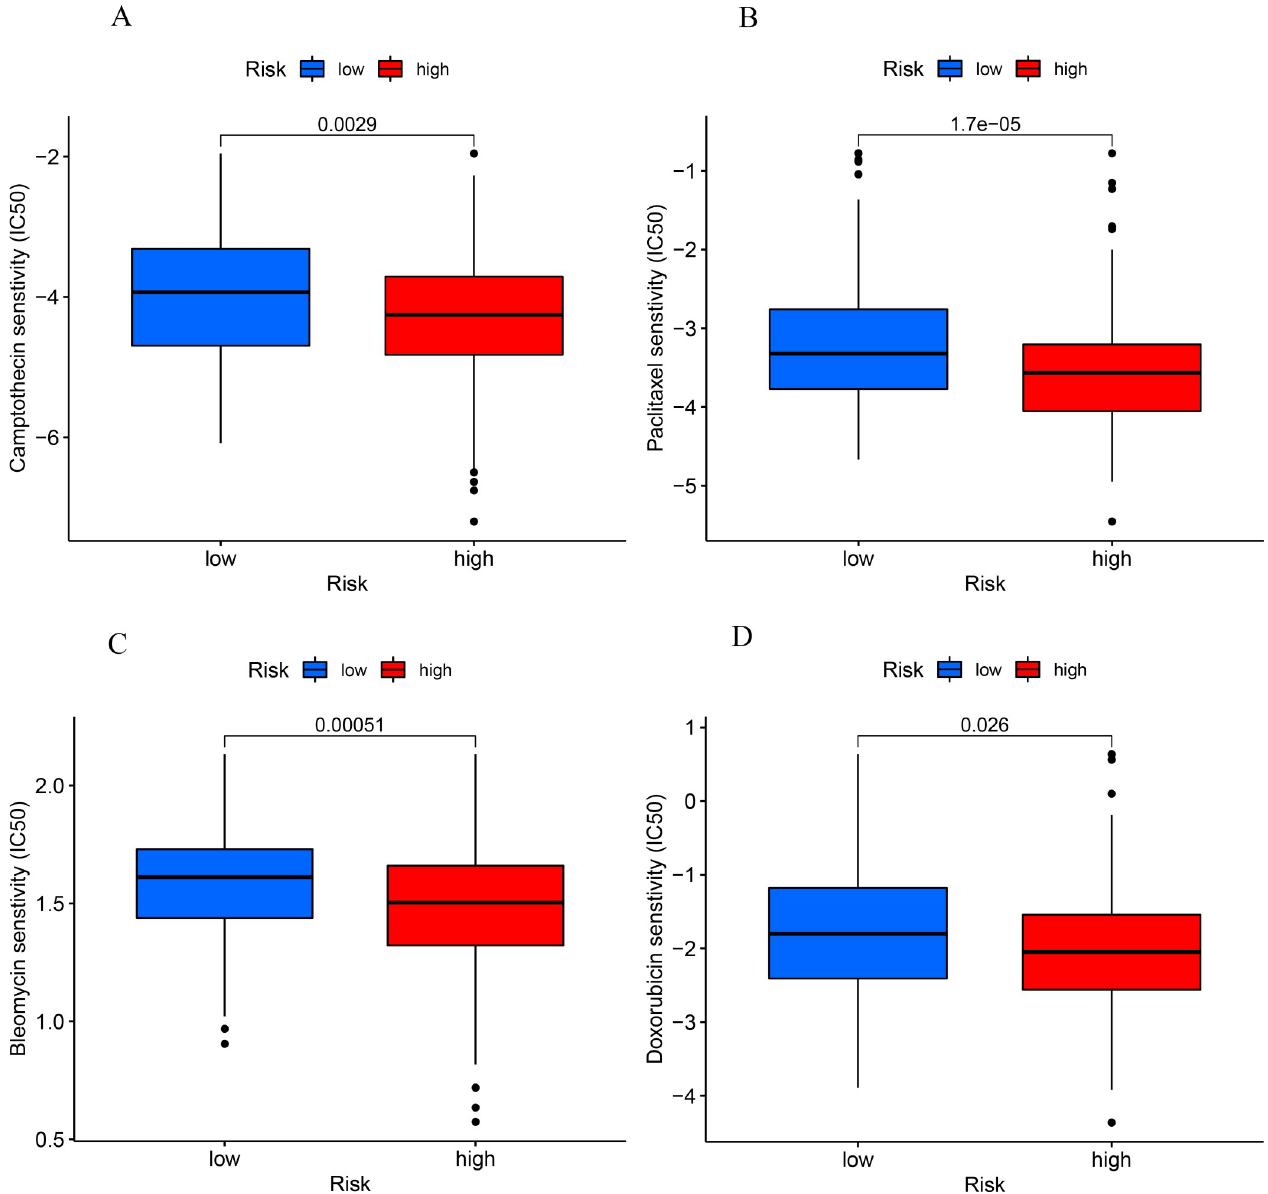
Fig 9. Sensitivity to camptothecin (A), paclitaxel (B), bleomycin (C) and doxorubicin (D) was significantly higher in the high- than low-risk